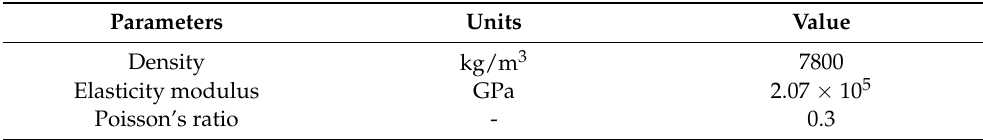
Table 3. Blade parameter